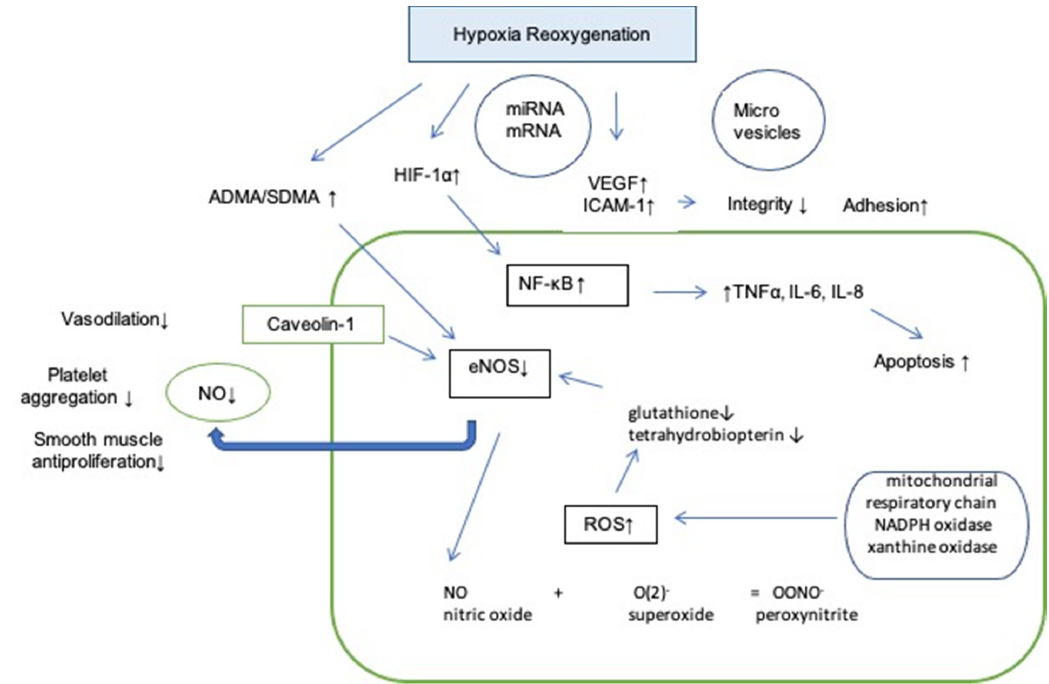
Figure 2. Influence of hypoxia reoxygenation on endothelium. Abbreviations: HIF-1 α : hypoxia inducible factor 1 alpha; VEGF: vascular endothelial growth factor; ICAM-1: intercellular adhesion molecule 1; NF- κ B: nuclear factor kappa-light- chain-enhancer of activated B cells; TNF α : tumor necrosis factor alpha; IL-6: interleukin 6; IL-8: interleukin 8; SDMA: symmetric dimethylarginine; ADMA: asymmetric dimethylarginine; ROS: reactive oxygen species; eNOS: endothelial ni- tric oxide synthase; NO: nitric oxide; ↑: increased; ↓: decreased.